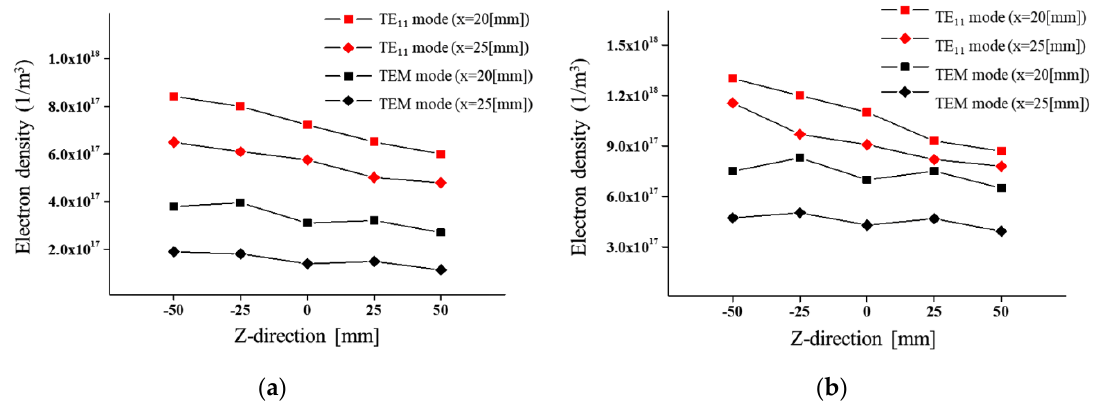
Figure 14. ( a ) Electron density at the substrate (Experiment) and ( b ) electron density at the substrate (Simulation).